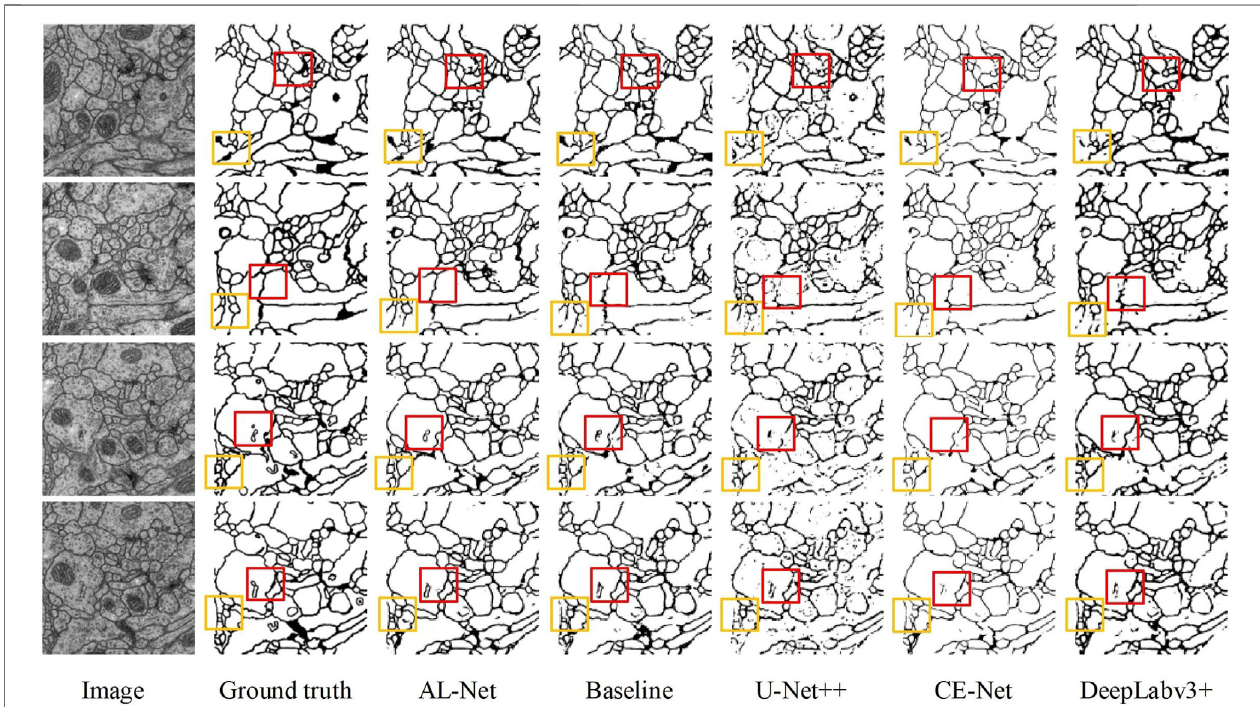
FIGURE 6 | The segmentation results of fi ve models for cell contour images. The red and yellow boxes respectively represent the segmentation differences of fi ve models in the same position.